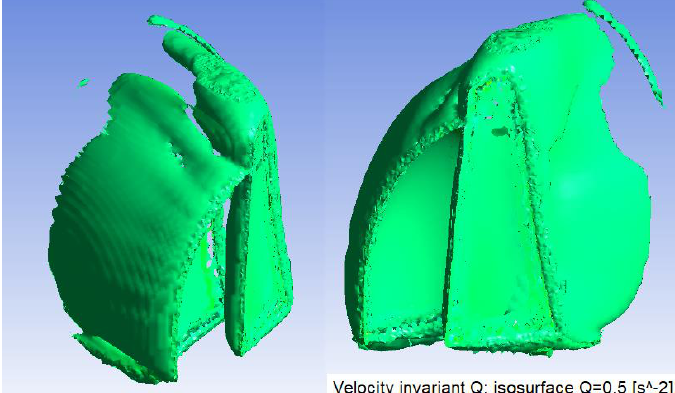
Figure 9. Iso-surfaces of Q-criterion for AWA = 90°.